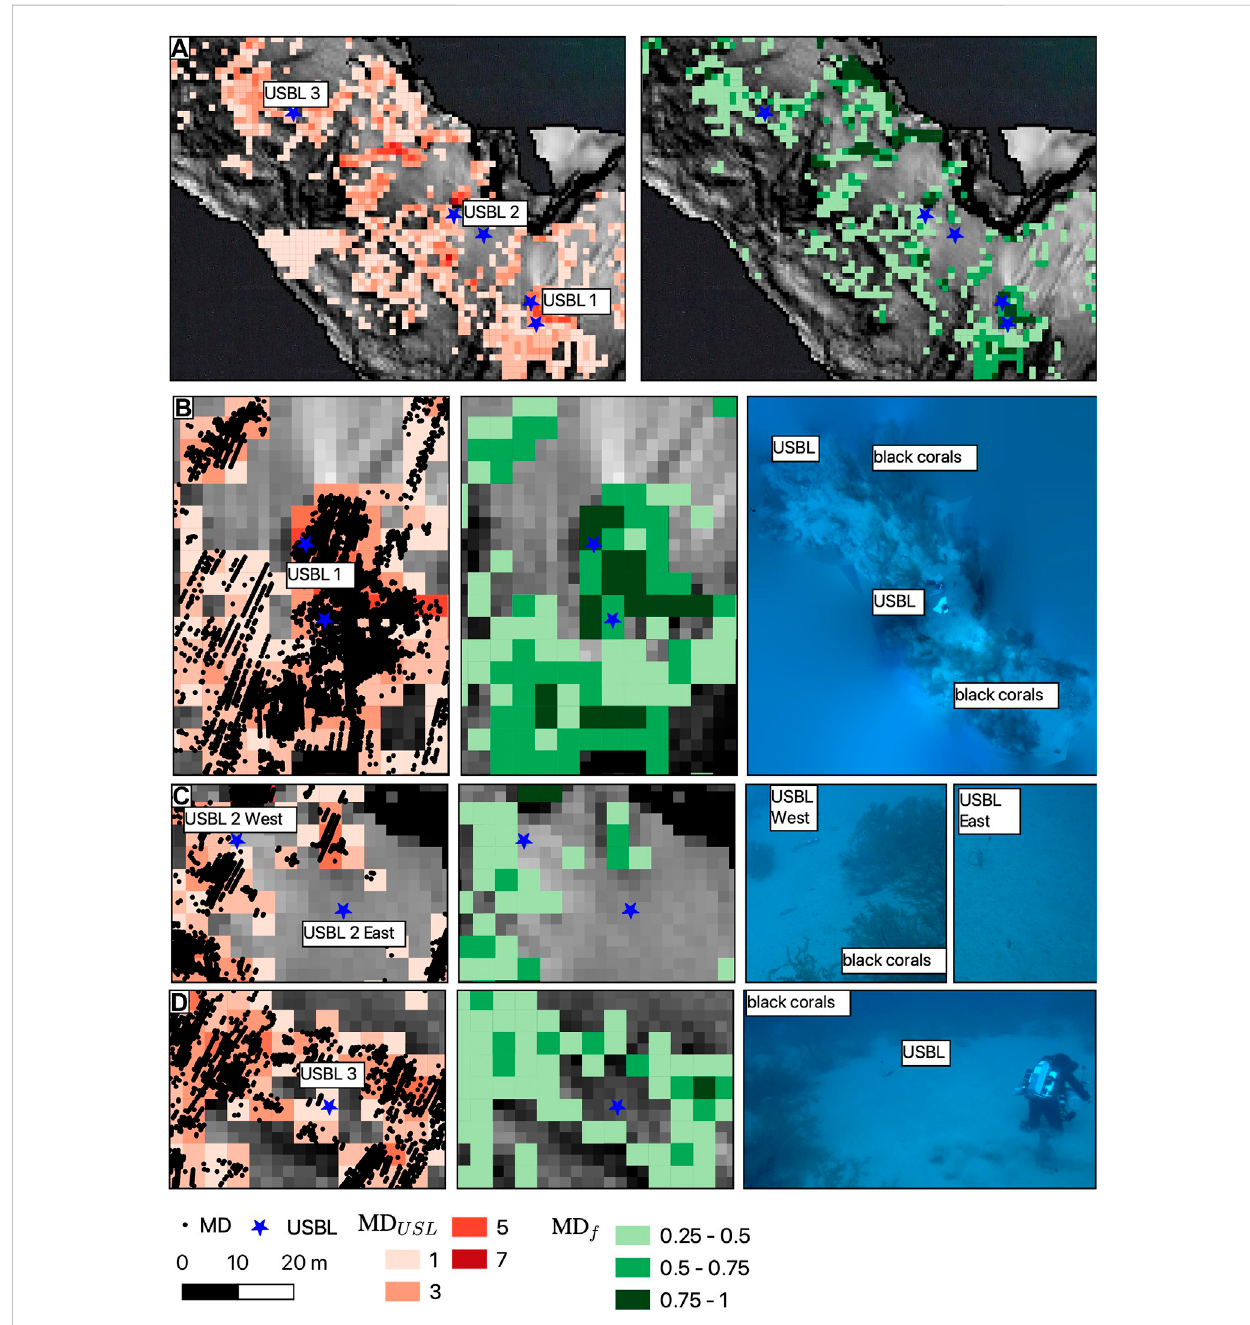
FIGURE 6 Grid of MD USL and MD f (A) for the location with diver ground truthing, showing black coral occurrence at USBL sites 1 (B) , 2 (C) and 3 (D) . For USBL site 1, a photo mosaic was created from a diver-recorded video.